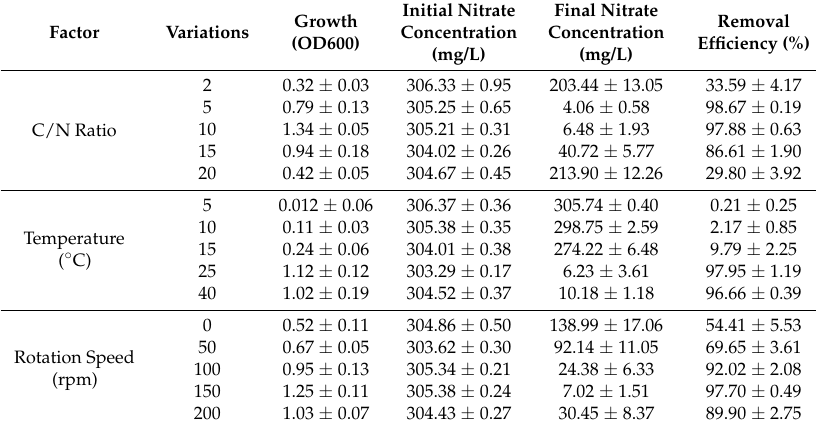
Table 2. Effects of varied single factors on the aerobic denitrification performance of strain RAD-2 after 48 h of incubation.